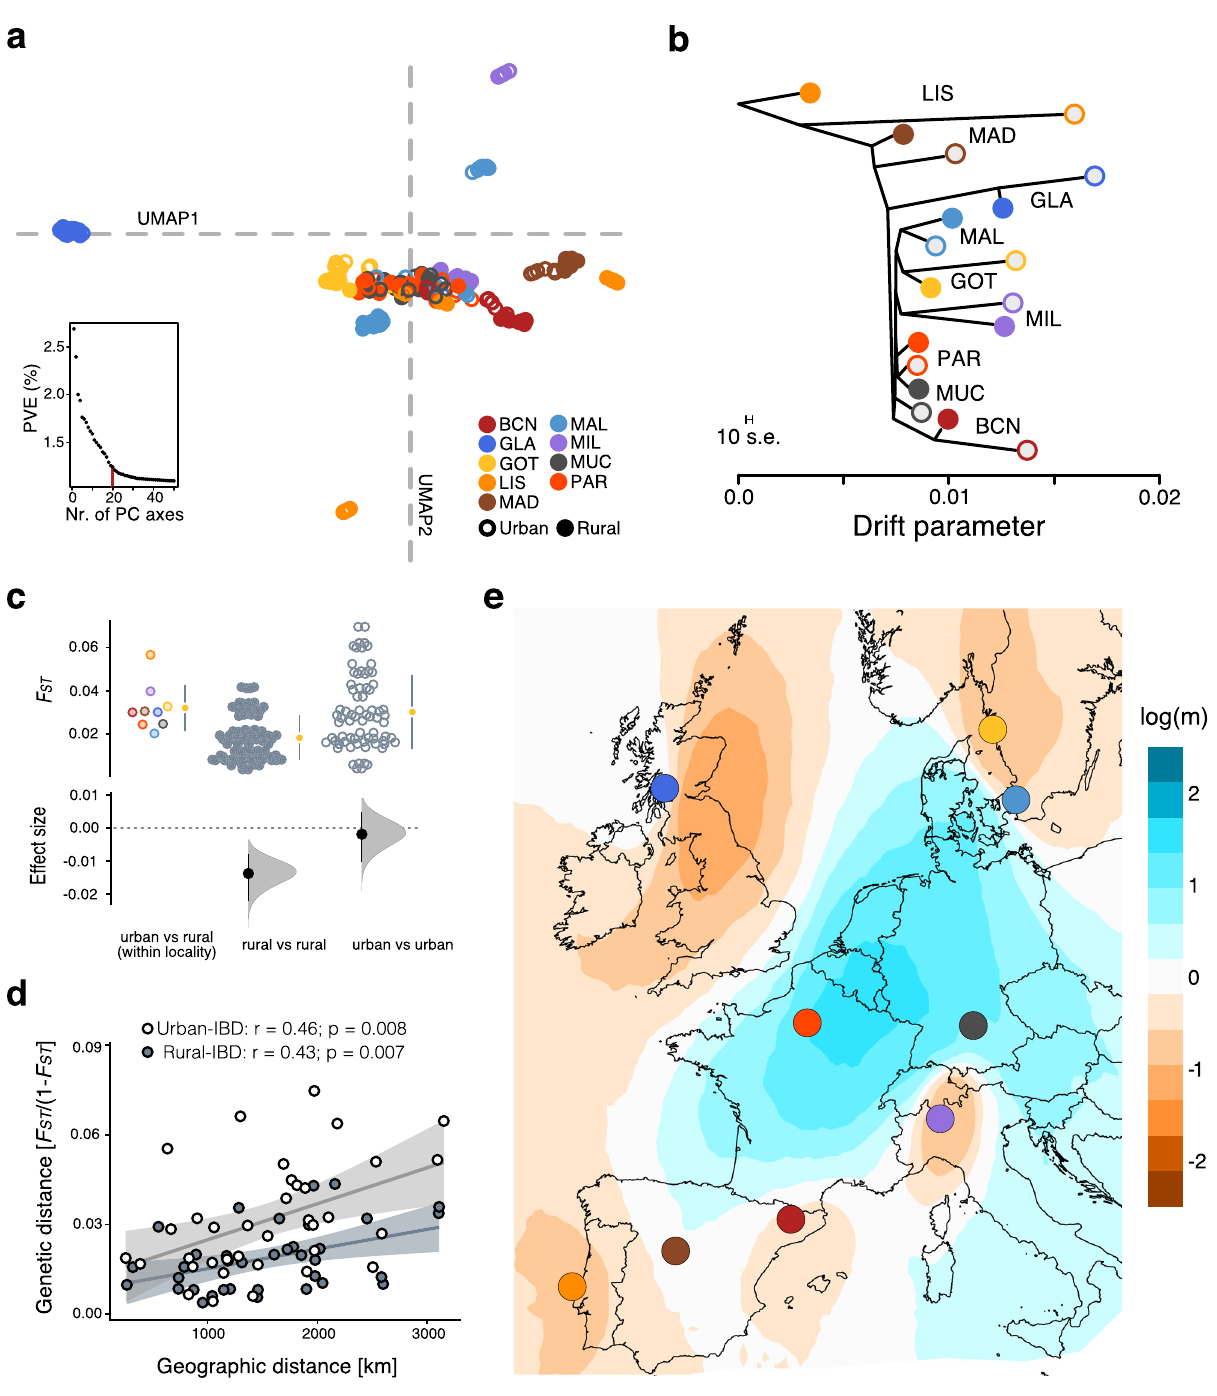
Fig. 2 Great tit population structure. a UMAP reduction of the fi rst 20 principal component axes for an LD-pruned SNP dataset, excluding the Z- chromosome and small linkage groups. The insert shows the percent of variance explained (PVE) by each of the fi rst 50 PC axes. The corresponding principal component plots can be found in Supplementary Fig. 2. b Population tree generated with TreeMix showing the relationship of urban (open circles) and rural (closed circles) populations from all sampling locations. c Comparison of F ST value distributions (mean ± SD) across population and habitats. The effect size plots (mean ± 95% bootstrap CI) show that overall rural populations (rural vs rural) display lower differentiation than the studied population pairs (urban vs rural), but not lower than urban populations (urban vs urban). d Isolation-by-distance analyses (Mantel ’ s test) for urban (open circles, light shaded, n = 72) and rural (closed circles, dark shaded, n = 72) populations separately. Shaded area denotes the 95% CI. e Effective migration surfaces for great tits across Europe. Negative log migration rates [log( m )] depict areas with less gene fl ow than expected under an isolation-by-distance model, whereas positive migration rates indicate stronger gene fl ow. Note that migration rates outside the central part of the sampling distribution are generally low, also between closely related cities. BCN Barcelona, GLA Glasgow, GOT Gothenburg, LIS Lisbon, MAD Madrid, MAL Malmö, MIL Milan, MUC Munich, PAR Paris. Colour code is given in panel a . Source data are provided as a Source data fi